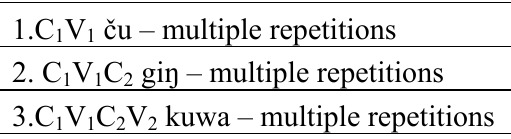
Table 3. Snake and frog call